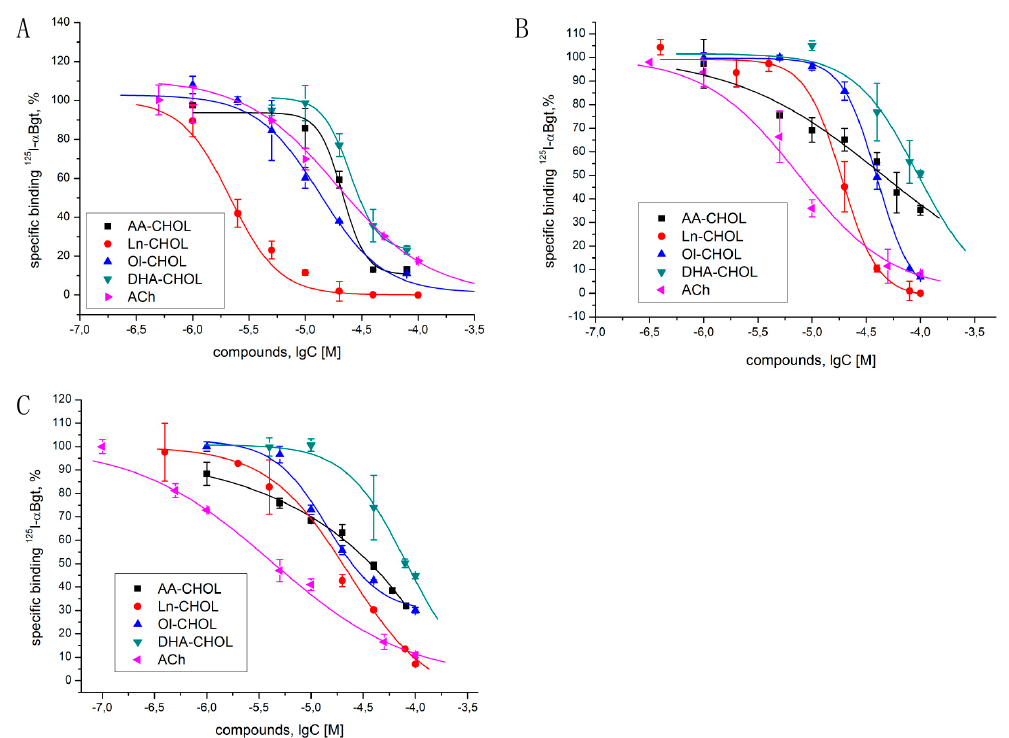
Figure 2. Competition of [ 125 I]-labeled α Bgt with acylcholines for binding to ( A ) L.stagnalis AChBP; ( B ) Torpedo californica nAChR; and ( C ) human α 7 nAChR expressed in the GH4C1 cell line. IC 50 values and 95% CIs are presented in Table 1. Each point is the mean ± SEM value of two measurements for each concentration in two (for DHA-CHOL with T. californica and α 7 nAChR) or three (all other cases) independent experiments.